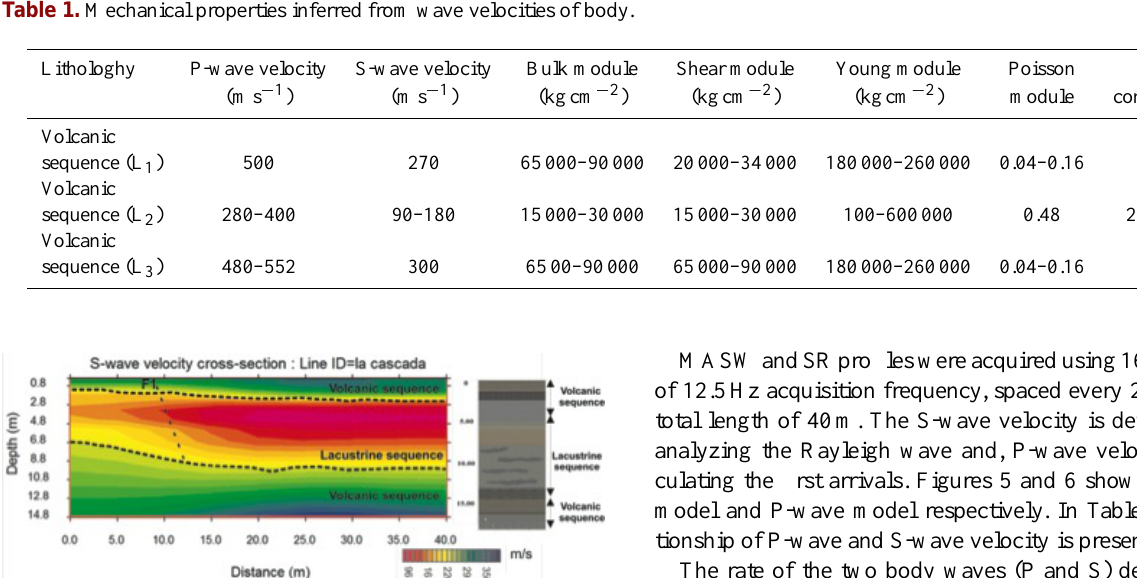
Figure 4. Reflection Profile of GPR. (a) Profile without geological interpretation; (b) profile with geological interpretation and CMP data correlation. Table 1. Mechanical properties inferred from wave velocities of body.